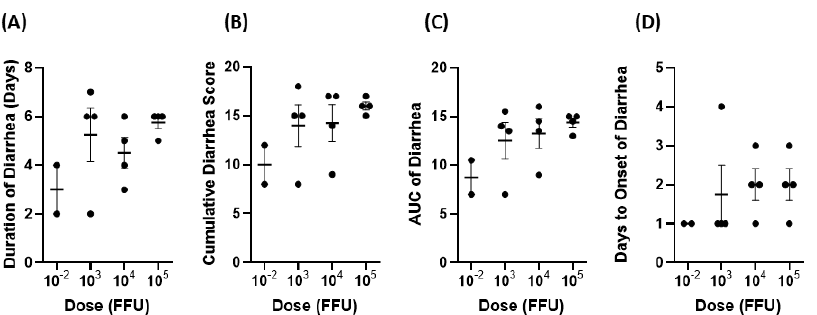
At all dose levels (10 − 2 , 10 3 , 10 4 , 10 5 ), all pigs developed diarrhea and shed the virus in feces. In general, there was a positive association between the dosage and severity of clinical signs of infection despite being statistically insignificant by Spearman’s correlation test. Pigs in the 10 5 group had diarrhea for longer than pigs in the lower dose groups (Figure 4A). The mean duration of days of diarrhea was 5.75 for the 10 5 group versus 4.5, 5.25, and 3 for the 10 4 , 10 3 , and 10 − 2 groups, respectively. The mean cumulative fecal score and the AUC of diarrhea were also positively correlated with dosage (Figure 4B,C). Pigs in the 10 5 group had 16 and 14.38 for the mean cumulative fecal score and AUC of diarrhea, respectively. In comparison, the remaining groups had mean cumulative fecal scores ranging from 10–14.25 and an AUC of diarrhea from 8.75–13.51. Mean days to onset of diarrhea were comparable across all groups (Figure 4D).